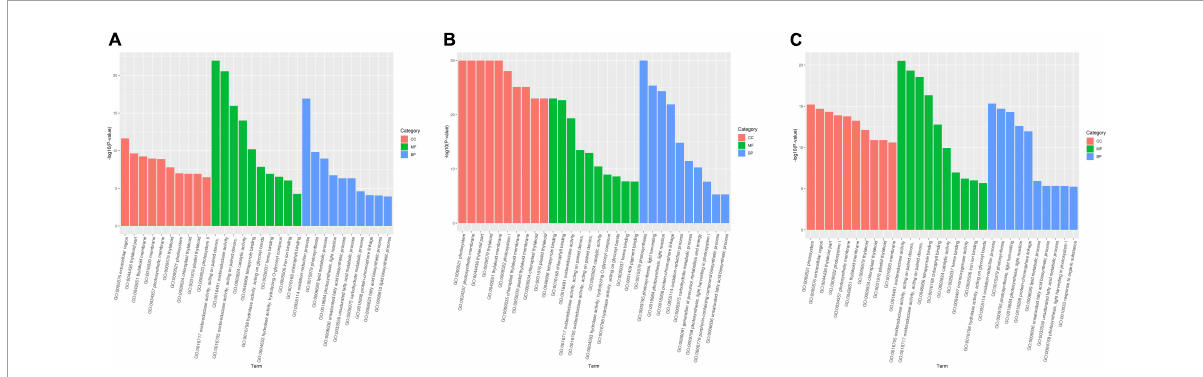
FIGURE2 Histogram of GO classification. (A) DEGs in R1 comparison, (B) DEGs in R2 comparison, (C) DEGs in R3 comparison. The DEGs were annotated into three main categories: biological process, cellular component and molecular function. R1, CK vs. SCPM; R2, CK vs. SCPMA; R3, CK vs.